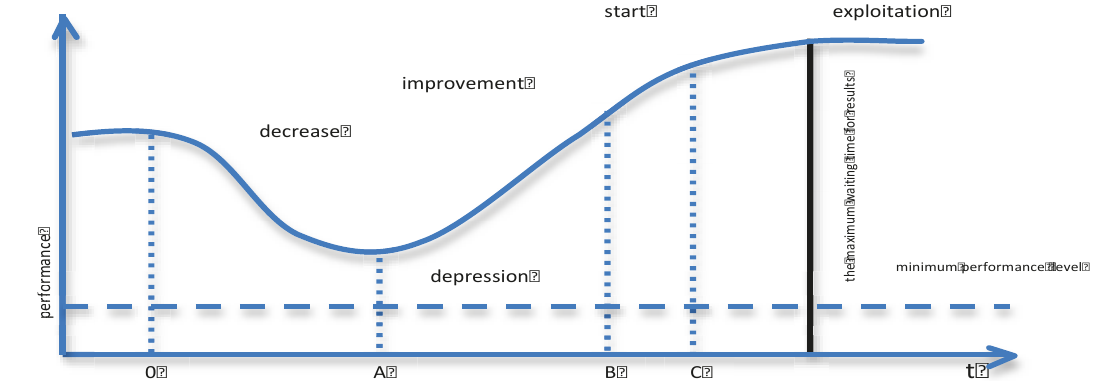
Figure 4. The e ffi ciency of the institutions in the period of change. Source: own, on the basis of Figure 4. The efficiency of the institutions in the period of change . Source: own, on the basis of [45].